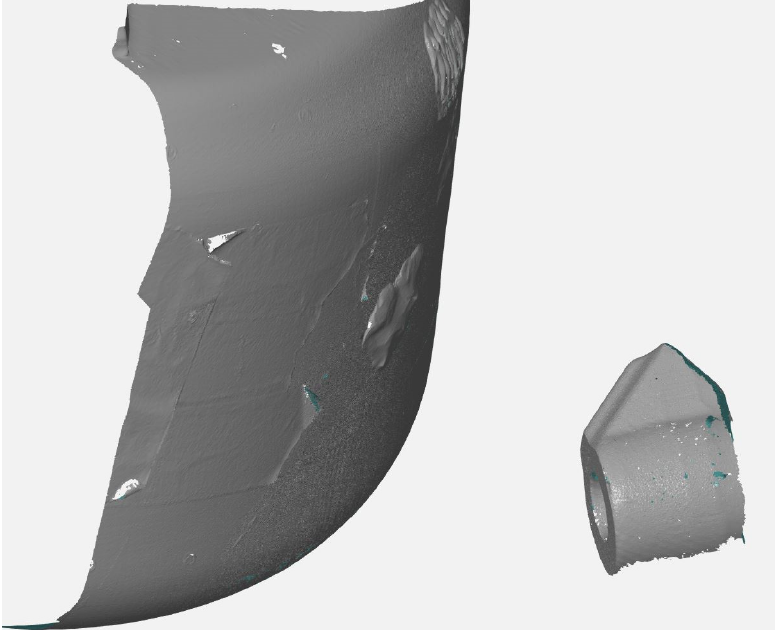
Figure 19. Scanning grids of the cutting head side surface and pick holder, imported into GOM Inspect Professional (GOM GmbH, Braunschweig, Germany).